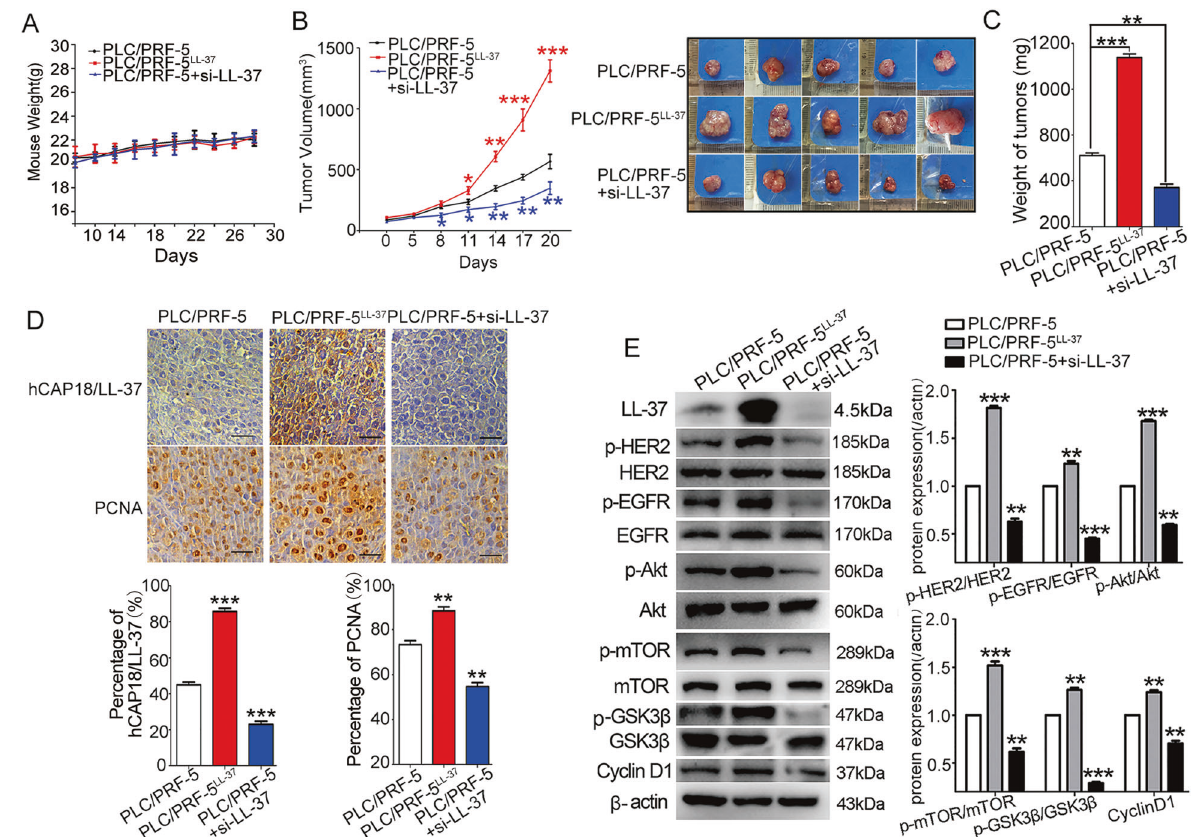
Fig. 6 LL-37 expression promotes PLC/PRF-5 xenograft tumor growth. PLC/PRF-5 and PLC/PRF-5 LL-37 cells were subcutaneously injected into nude mice (4 – 6 weeks old) to form xenograft mouse models and were assigned into three groups: PLC/PRF-5 xenograft mouse group (control group), PLC/PRF-5 LL-37 xenograft mouse group, and PLC/PRF-5 xenograft mouse group treated with si-LL-37. Mouse weight ( A ) and tumor volumes ( B ) were determined every 2 days and tumor growth curves over time was illustrated. B Mice were sacri fi ced on day 28 and tumor weight ( C ) was measured. D Paraf fi n sections were prepared for immunohistochemical staining using anti-hCAP18/LL-37 and anti-PCNA antibodies. Representative images from each group are shown. Scale bars, 50 μ m. E Tumor tissues were crushed, lysed with RIPA lysis buffer, and supernatants were collected for western blotting using the indicated antibodies. Error bars represent the mean ± standard deviation, n = 5. * p < 0.05, ** p < 0.01, and *** p <